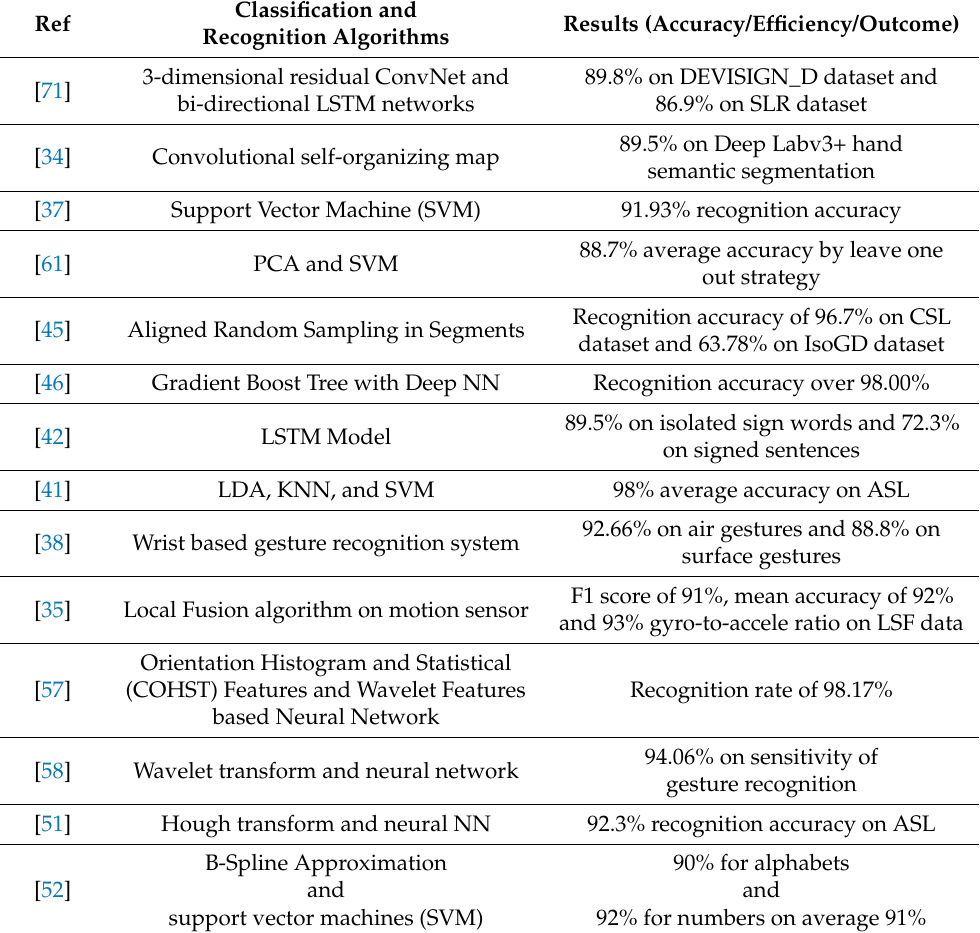
Table 5. Results analysis of algorithms used for classification and